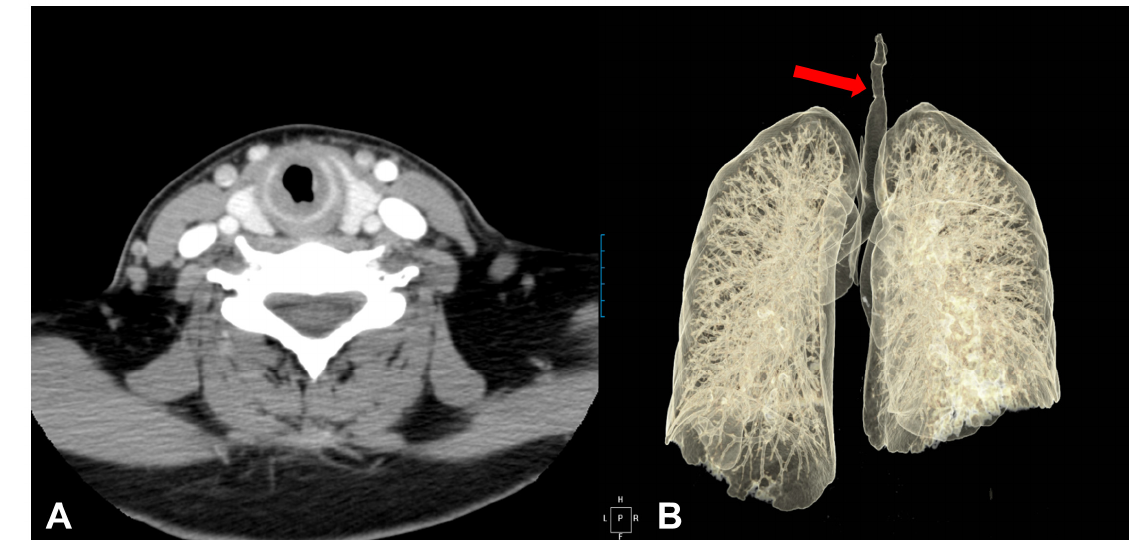
Figure 1. A chest computed tomography scan of the larynx and trachea revealed the subglottic stenosis with concentric circumferential thickening of the mucosa ( A ), and thickening of cricoid cartilage level to the medial level of the thyroid gland ( B ).